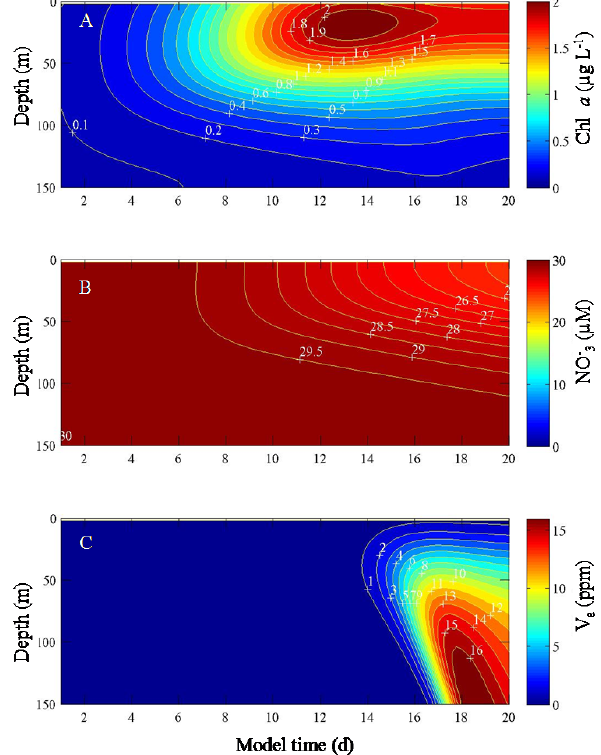
Figure 9. Model results for vertical distribution through time of phytoplankton (µgChlL − 1 ) ( A ; phytoplankton concentration does not include any algae present in aggregates), nitrate (µM) (B) , and V Ta (ppm) (C) . Contour interval is 0.1µgChlL − 1 (A) , 0.5µM (B) , and 1ppm (C) . The calculation assumes that the UVP only mea- sures aggregates larger than